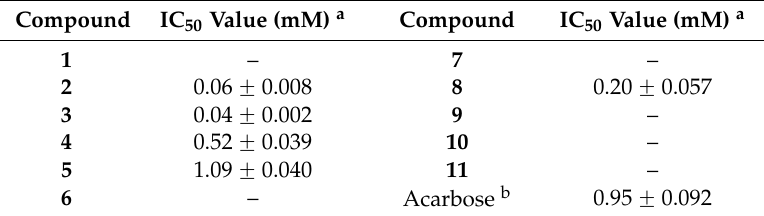
Table 4. In vitro α -glucosidase inhibitory activities of compounds 1 – 11